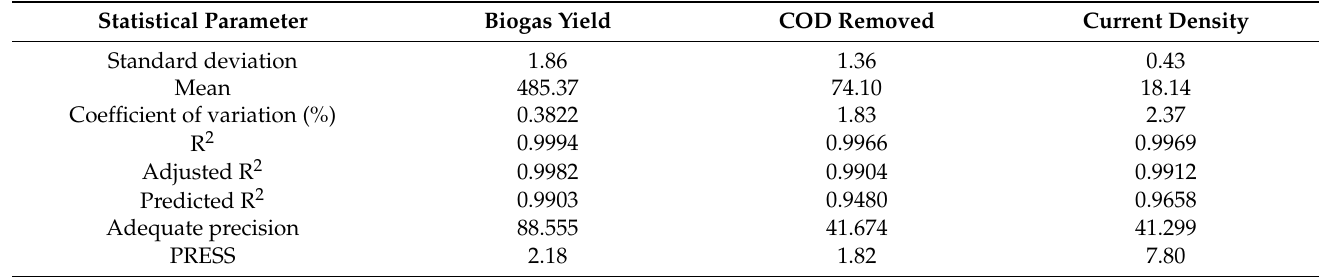
Table 8. Fit statistics for biogas yield, %COD removed, and maximum current